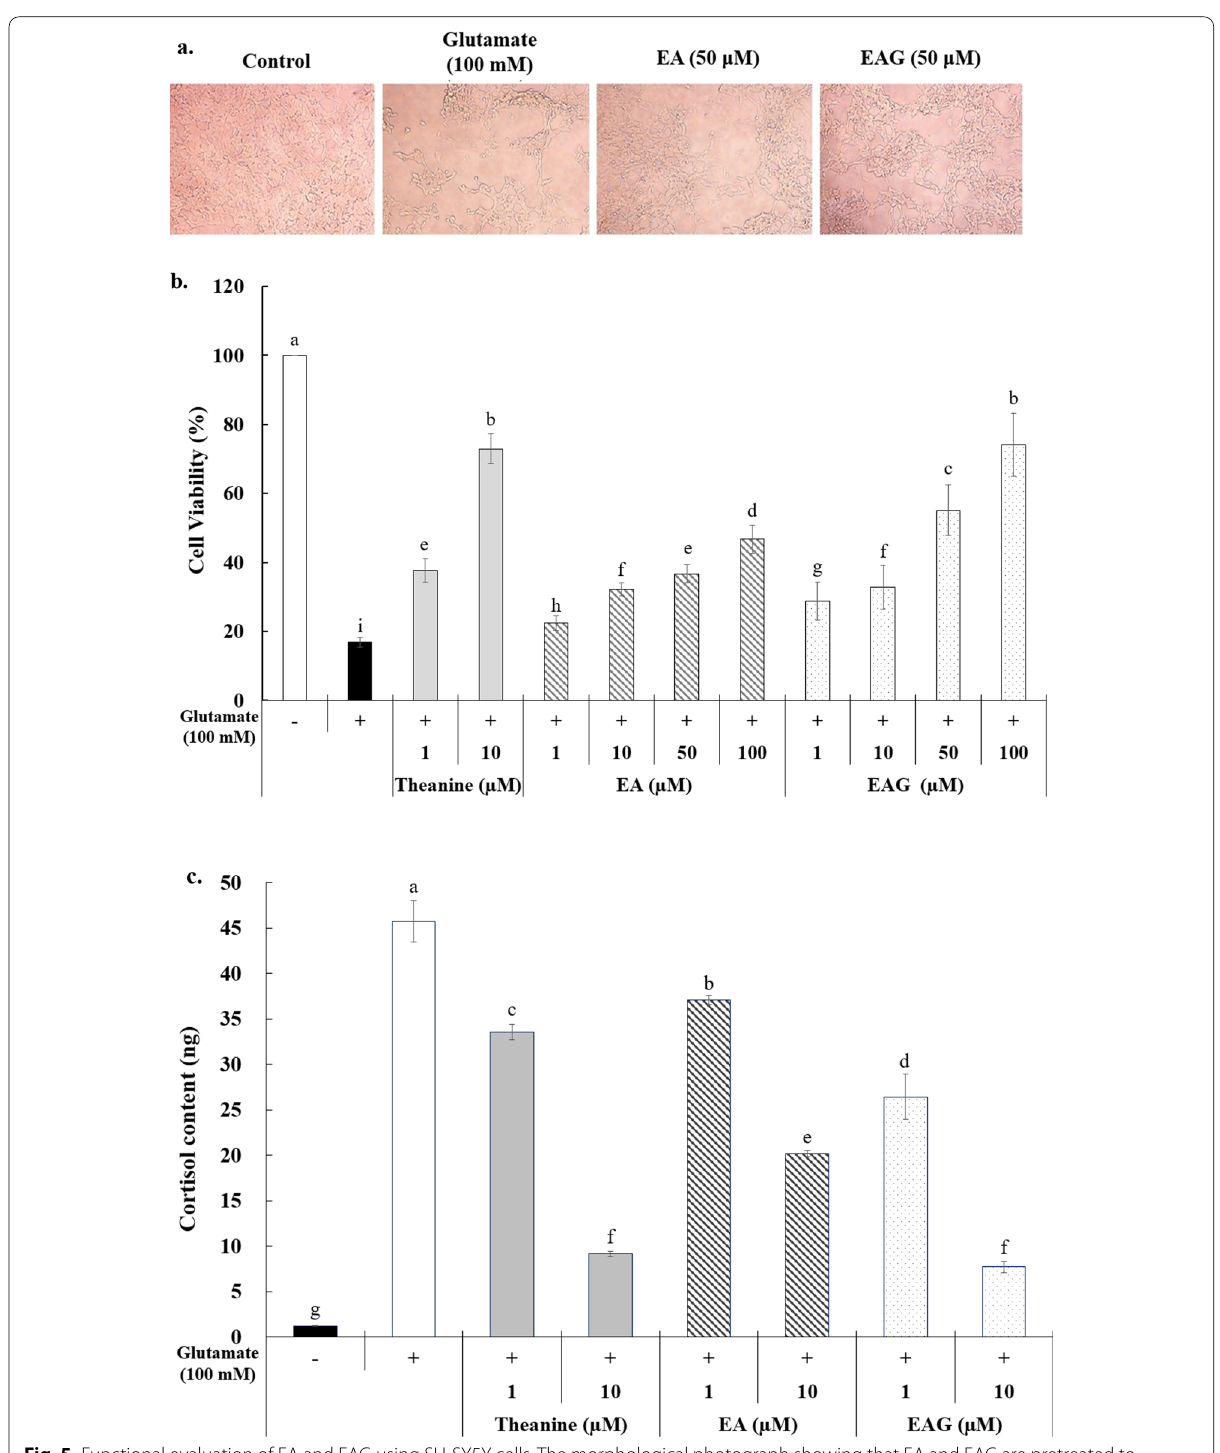
Fig. 5 Functional evaluation of EA and EAG using SH‑SY5Y cells. The morphological photograph showing that EA and EAG are pretreated to prevent cell damage from glutamate treatment ( a ). Cell viability according to treatment with 1–100 μM of EA or EAG compared with only buffer treatment. As positive controls, 1 and 10 μM of theanine were treated ( b ). Cortisol content in the cells treated with 1 or 10 μM theanine, EA, or EAG before treatment of glutamate ( c ). Inhibition rate of AChE enzyme after treatment with 100 mM glutamate followed by treatment with 10 μM tacrine, 50 or 100 μM of EA or EAG ( d ). Mean with same letter in each column are not significantly different by Duncan’s multiple range test ( p <